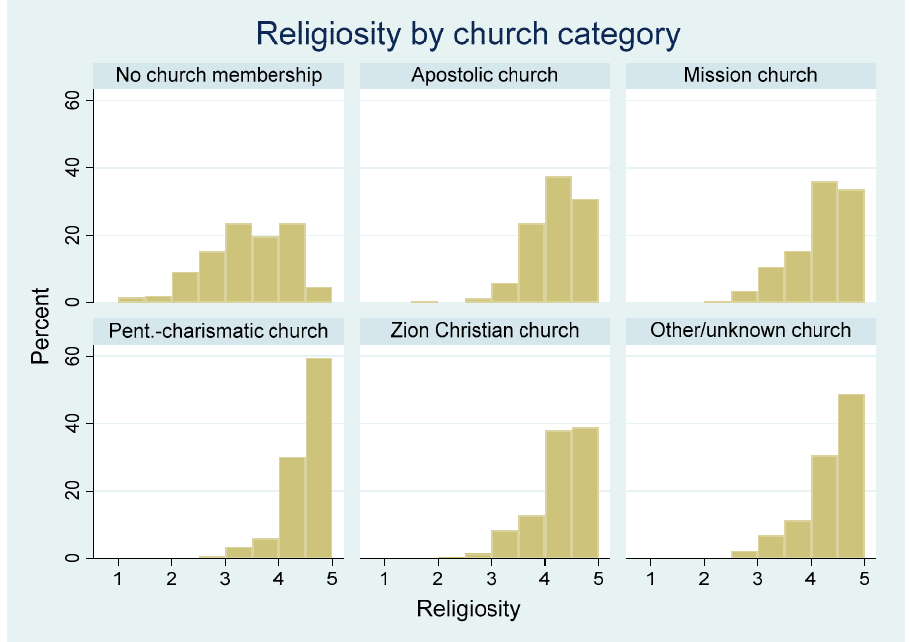
Figure 2. CRS by church category. Note—Figure shows the distribution of individual religiosity according to the different categories of churches in the sample, measured according to the Centrality of Religiosity Scale, CRS (Huber and Huber 2012). A value less than or equal to 2 indicates “non-religious” persons, values between 2 and 4 indicate “religious” persons, while a value equal to or greater than 4 is categorized as “highly religious”.